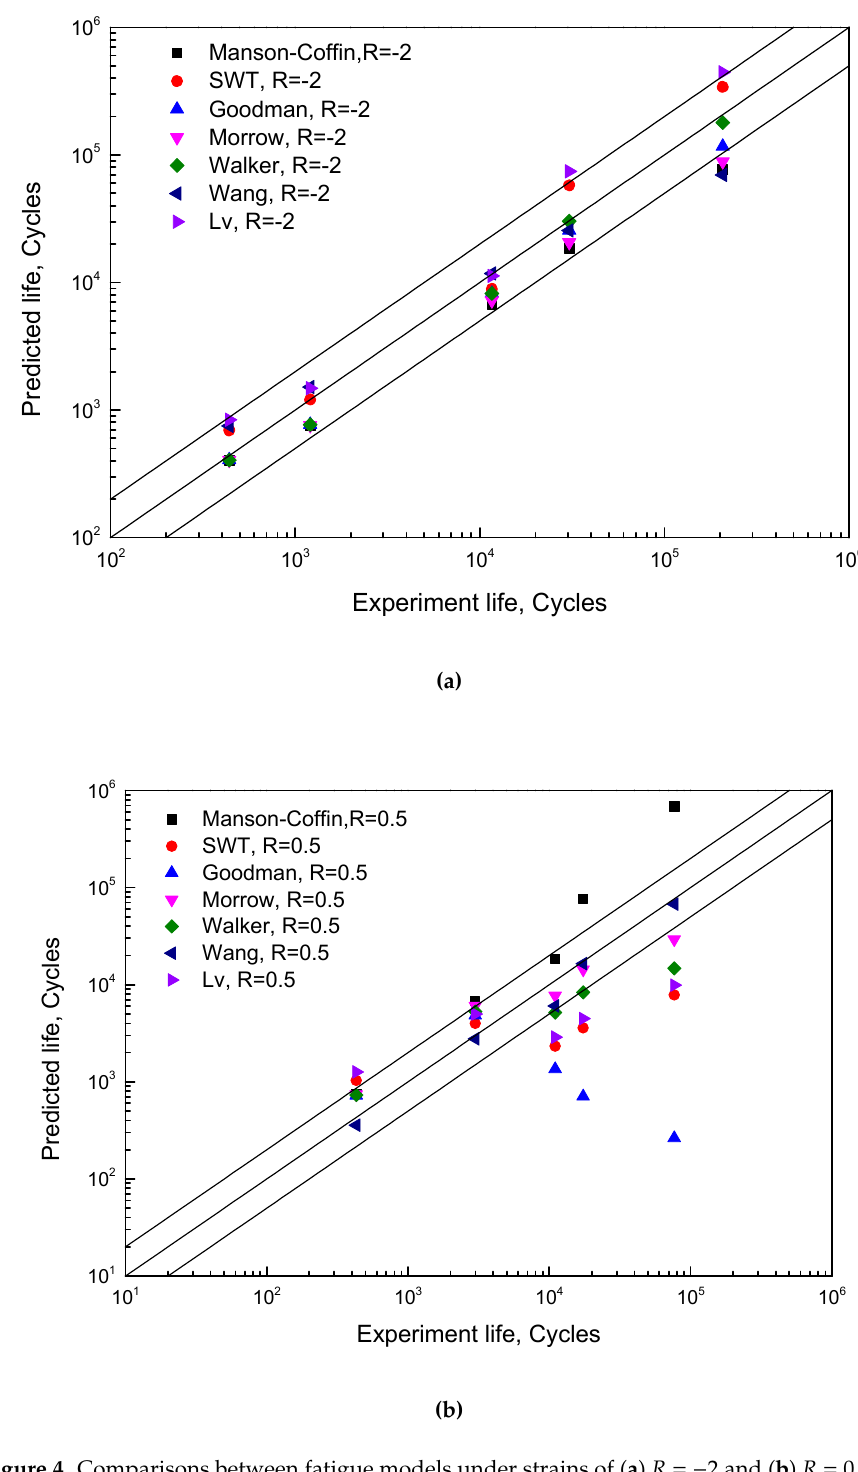
Figure 4. Comparisons between fatigue models under strains of ( a ) R = − 2 and ( b ) R = 0.5.